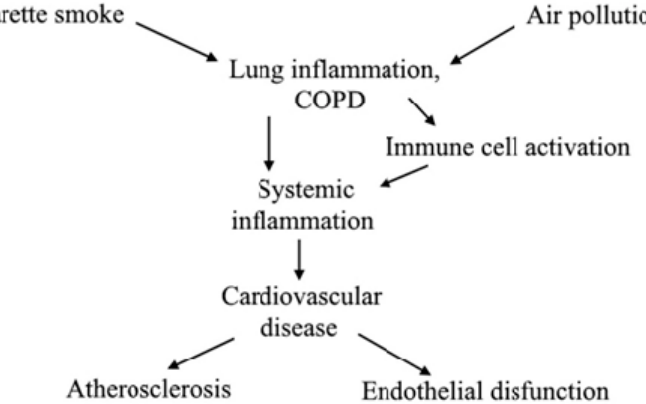
Figure 1. Exposure to cigarette smoke and air pollution activates immune cells [e.g., macrophages, neutrophils] which drive reactive oxygen species production and systemic inflammation. The process finally promotes cardiovascular diseases (CVD) and progression, ultimately leading to CVD-associated